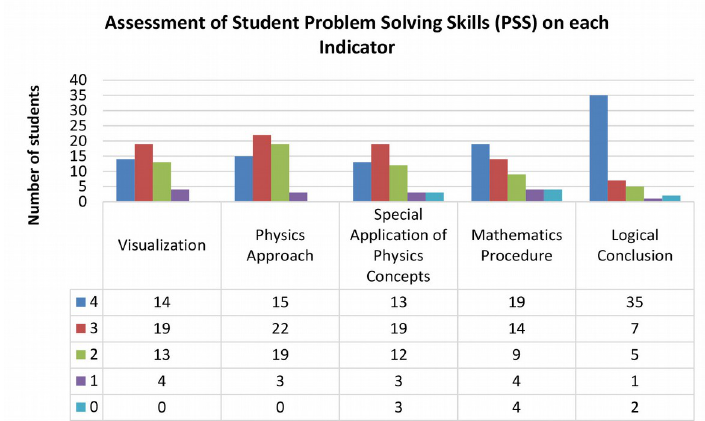
Figure 4. Assessment of student problem-solving skills (PSS) on each